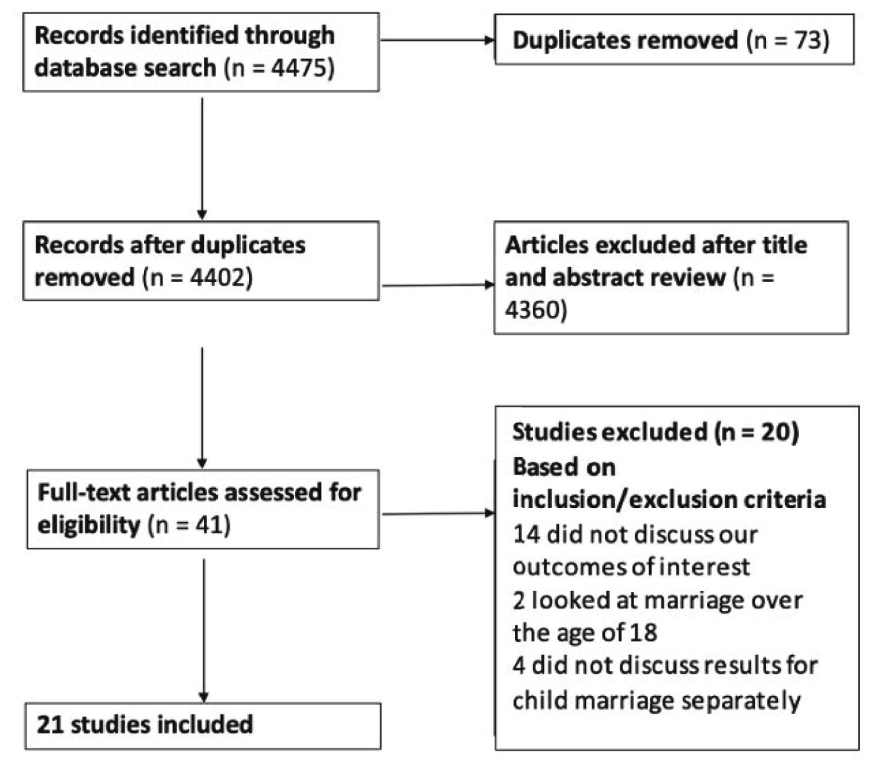
Fig 1. PRISMA flow diagram of studies included in the